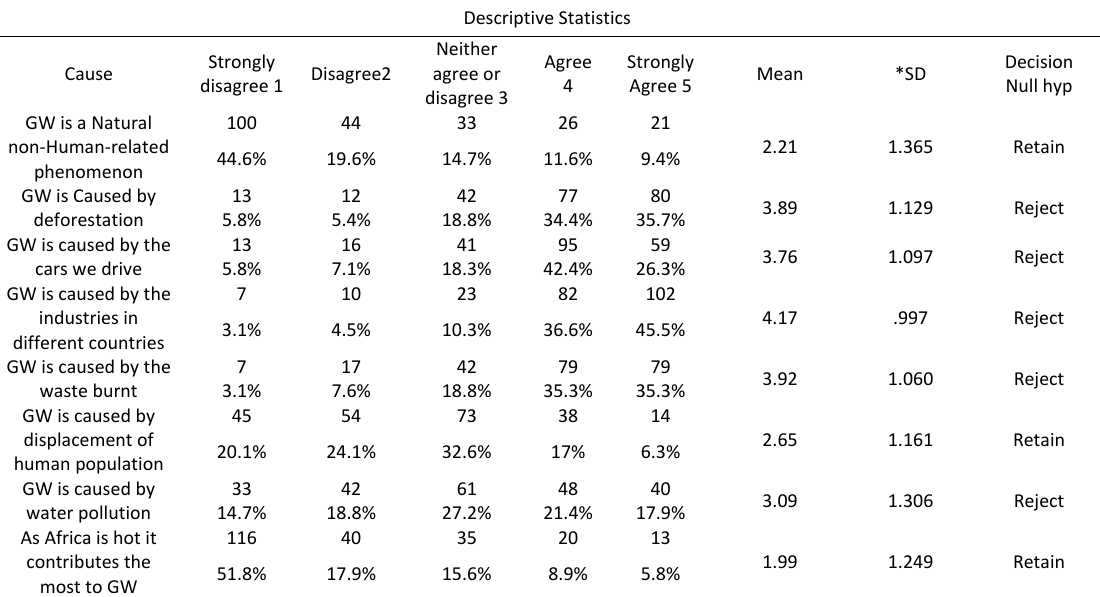
Table 2: Descriptive statistics results on GW causes